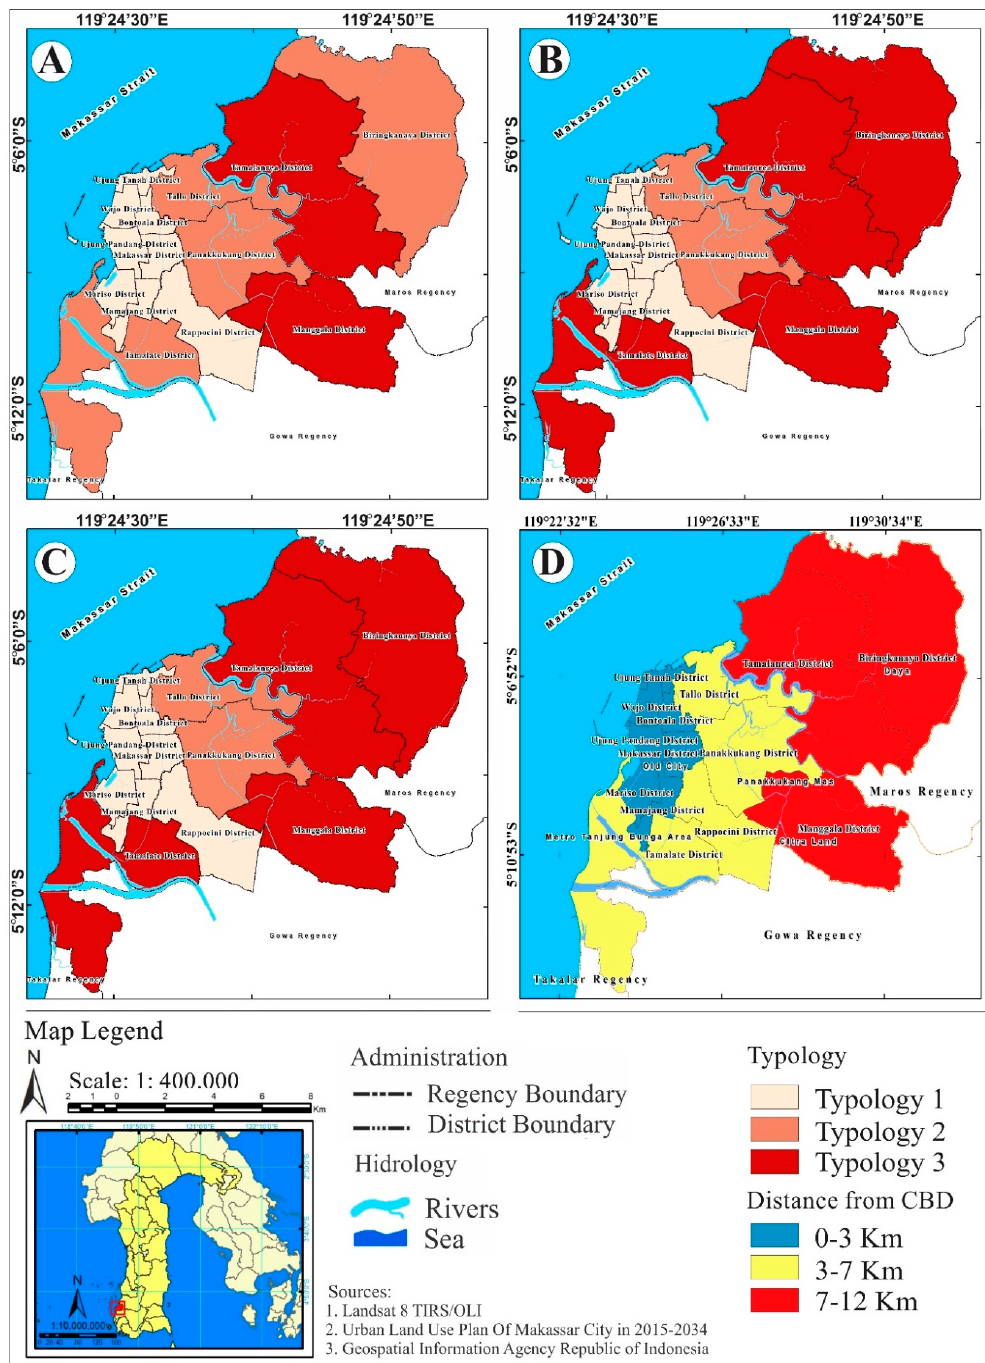
Figure A3. Differences in distance between districts to CBD locations and sprawl typology of Makassar City. ( A ) Year 2010, ( B ) Year 2015, ( C ) Year 2020, and ( D ) Distance to CBD.